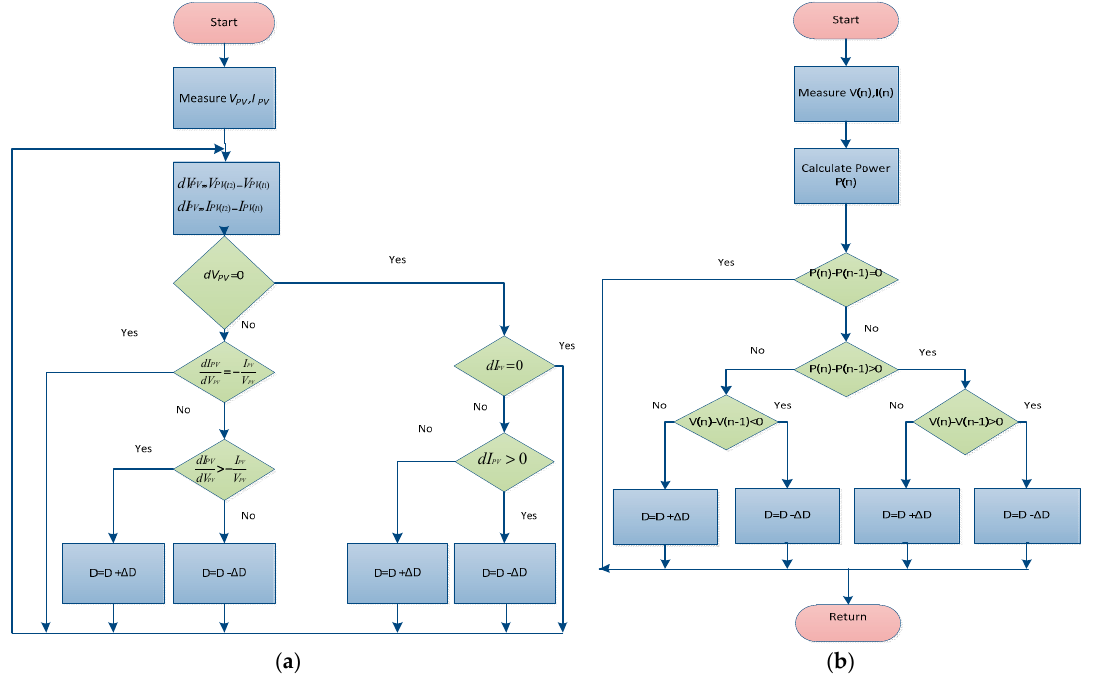
Figure 4. Flowchart of ( a ) incremental conductance (IC) and (b) perturb and observe (P&O) Methods.